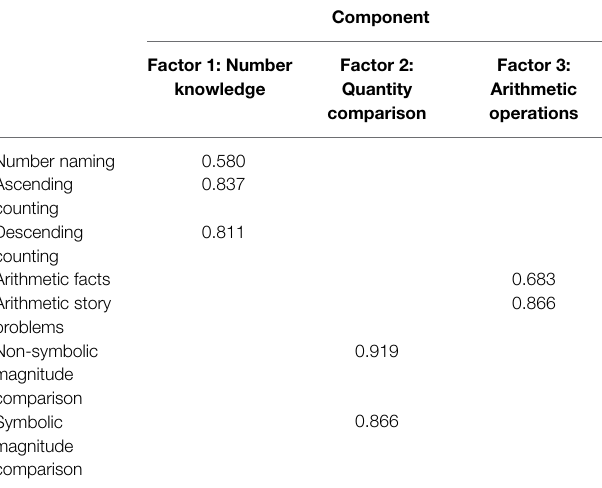
TABLE 2 | Loadings and factor division findings for the different numeracy